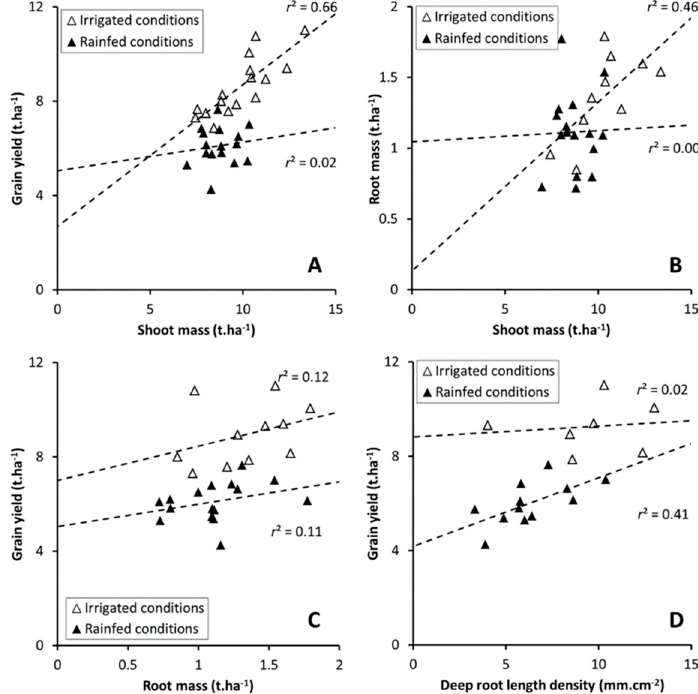
Figure 8. Relations between aerial traits and underground traits for wheat varieties. Correlations between shoot mass (t ha − 1 ) and grain yield (t ha − 1 ) ( A ), shoot mass (t ha − 1 ) and root mass (t ha − 1 ) ( B ), root mass (t ha − 1 ) and grain yield (t ha − 1 ) ( C ), deep root length density (mm cm − 2 ) and grain yield (t ha − 1 ) ( D ), at anthesis (Z65), in irrigated ( Δ ) and rainfed ( ▲ ) conditions. Determination coefficients are displayed on top right corner for irrigated and middle right for rainfed conditions. Since no correlation can be found between grain yield and shoot biomass under rainfed conditions, grain yield cannot be assessed from plant aerial characteristics before harvesting. In contrast, deep root length surface density is highly correlated to grain yield in rainfed conditions.